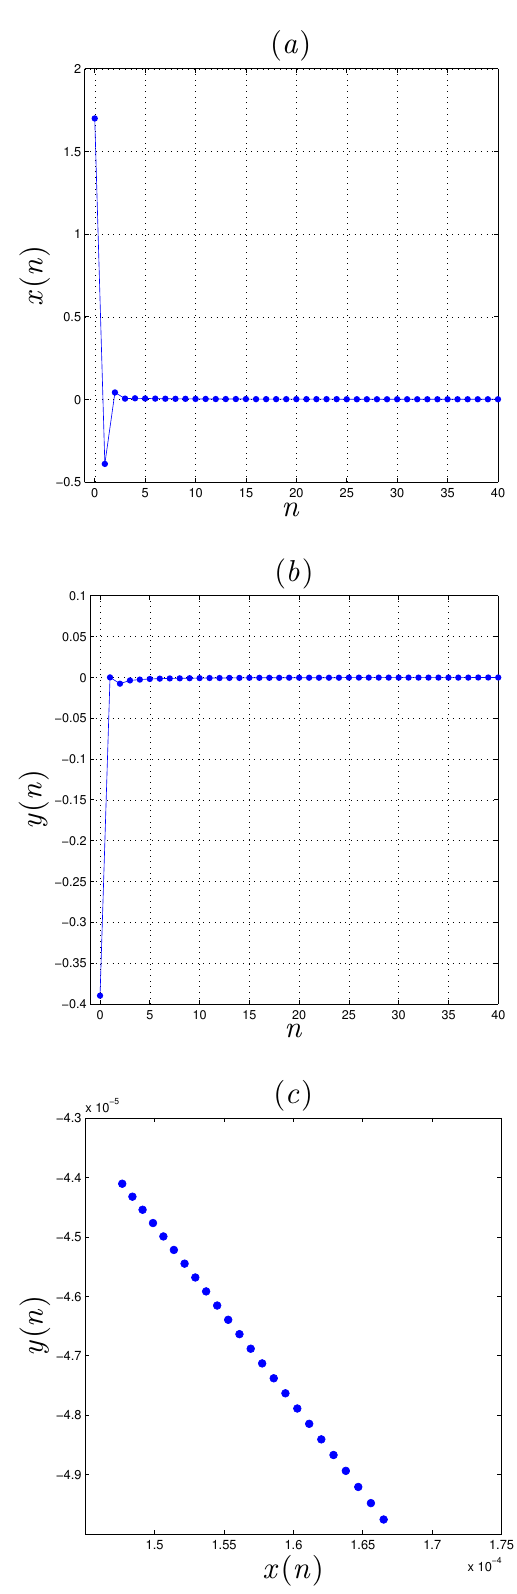
Figure 8. State and Phase trajectories of the fractional order map (6) after control: ( a ) evolution of state x ( n ) ; ( b ) evolution of state y ( n ) ; ( c ) phase